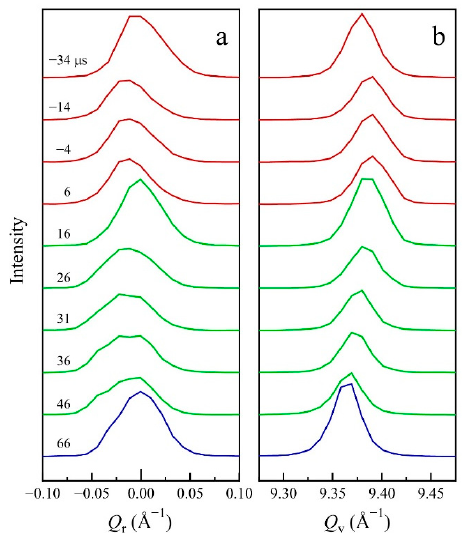
Figure 1a. Both Q r and Q v represent two-dimensional reciprocal space coordinates along the crystal rotation ω -axis and [001] parallel to the electric field, respectively (Figure 1a), (cid:112) Q r2 + Q v2 = 4 π sin θ / λ = 2 π / d ( d : d -spacing). where the scattering vector length is Q = A peak broadening along Q r and a peak shift along Q v , due to the polarization switching, can be seen in the time region from ∆ t = 16 to 46 µ s. The time dependences of the voltage and current between the two electrodes on the crystal surfaces were monitored by a digital oscilloscope from ∆ t = − 40 to 70 µ s, as shown in Figure 3a. A transient positive current peak caused by the polarization switching is clearly seen in the time region from ∆ t = 16 to 46 µ s with the maximum at ∆ t = 33 µ s.